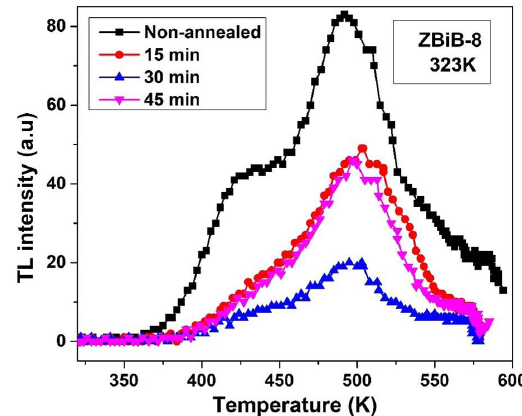
Figure 15. TL glow curve of thermally annealed ZBiB-8 glass at 323 K for different duration of